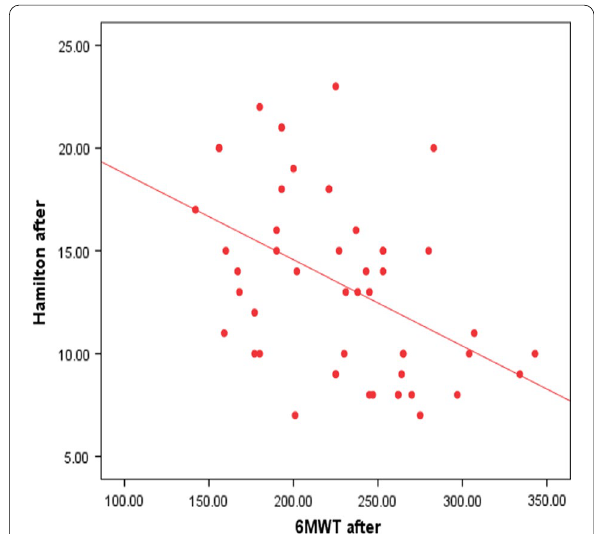
Fig. 2 Negative correlation between HDRS and 6MWT